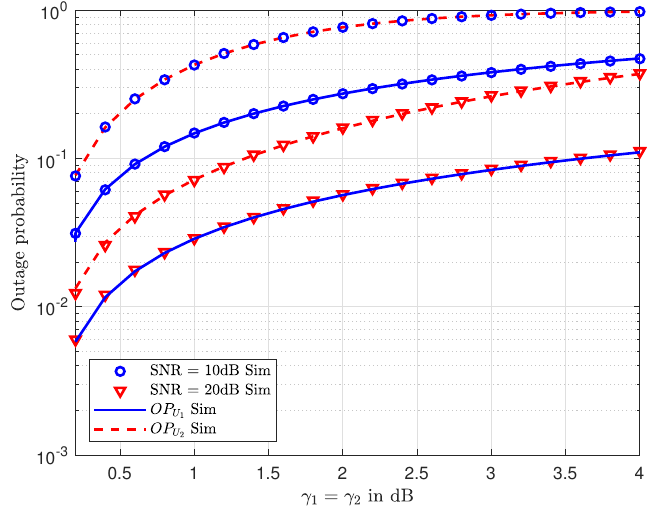
Figure 5. Outage probability of two users vs. target rates with SNR = 10, 20